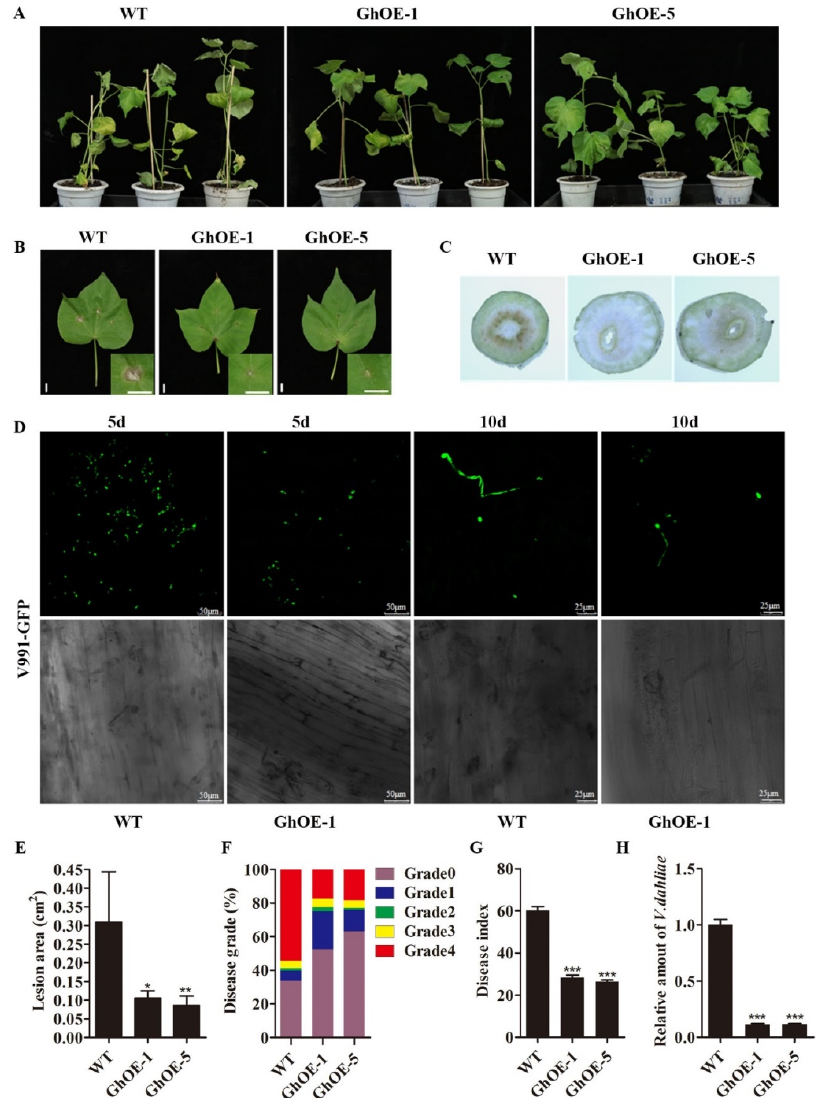
Figure 6. GhCYP710A1 overexpression in cotton with enhanced resistance to Verticillium dahlia . ( A ) Symptoms of cotton after Verticillium dahliae infection for 15 days. WT: wild-type cotton; GhOE-1 and GhOE-5: transgenic cotton lines. ( B ) Symptoms of cotton leaves after Verticillium dahliae infection for 5 days. Scale bar= 1 cm. ( C ) The cross-sections of cotton stem after Verticillium dahliae infection for 15 days; the brown area indicates the diseased vascular tissue. ( D ) The taproots of cotton seedlings with GFP fluorescence were observed under confocal microscope. WT: wild-type cotton; GhOE-1: GhCYP710A1 -overexpression transgenic cotton lines. ( E ) The lesions area statistics of cotton leaves after Verticillium dahliae infection. ( F ) Disease grade statistics. ( G ) Disease index statistics. ( H ) qRT-PCR was utilized to analyze fungal biomass in wild-type and transgenic cotton leaves after Verticillium dahliae infection for 15 days. DNA content of Verticillium dahliae internal transcribed